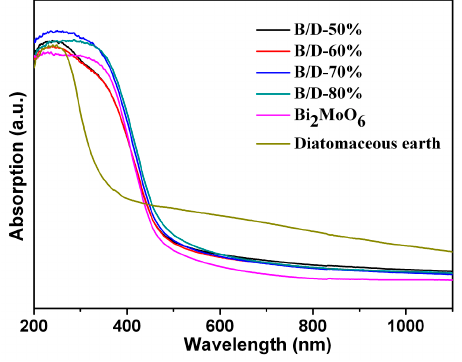
Figure 4. UV-vis DRS spectra of Bi 2 MoO 6 , B/D-50%, B/D-60%, B/D-70%, B/D-80%, and diatomite.